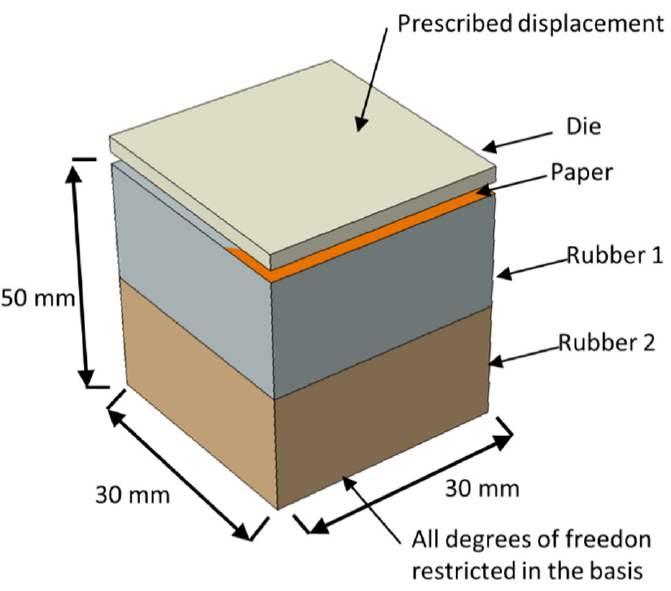
Figure 5. Model dimensions and boundary conditions.